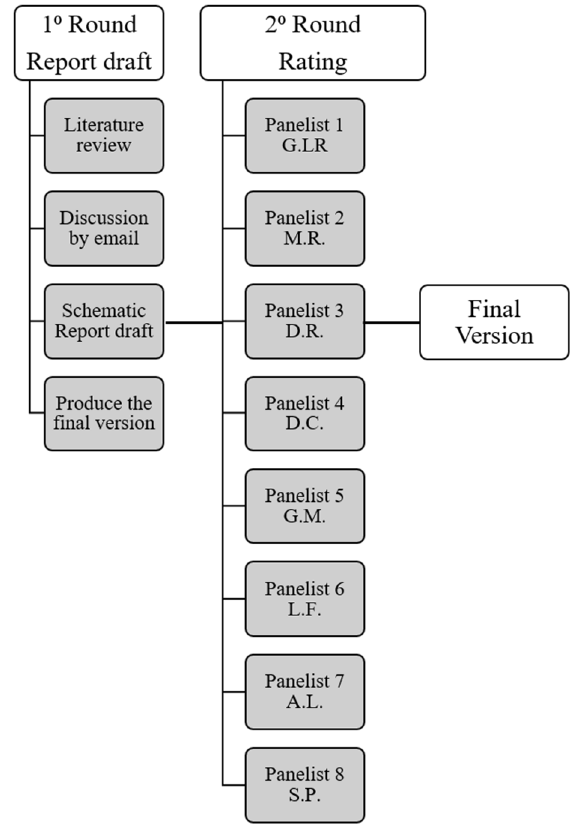
Figure 1. Delphi consensus flow-chart.